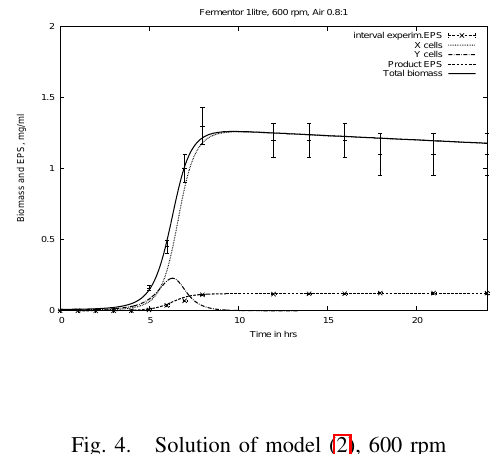
Fig. 4. Solution of model (2), 600 rpm Fig. 6. Solution of model (2), 100 rpm The values of the parameters numerically iden- The coefficients obtained for the best fit at tified in model (2) are as follows: k 1 = 5 . 8 , k 2 = various agitation rates reported in Figure 1 are 2 . 8 , k = 0 . 005 , α = 9 , β = 9 , γ = 1 . 7 , s (0) = given in Table II. d 0 . 9 , x (0) = 0 . 011 , y (0) = p (0) = p (0) = 0 . 1 The graphs of the solutions fitting the experimental data are visualized in Fig. 4. A very good fit of the biomass, as well as of the product EPS, can be observed. Model (2) has been fitted for the measurement data obtained with other agitation rates. The re- sults are always good within the accuracy of the C OEFFICIENTS OF MODEL (2) FOR VARIOUS AGITATION experimental measurements. Figures 5 and 6 are RATES examples of the results obtained for 500 rpm and 100 rpm. It can be seen from Table II that the two coeffi- cients α and β are always equal. An interpretation could be that newborn cells belong wth equal